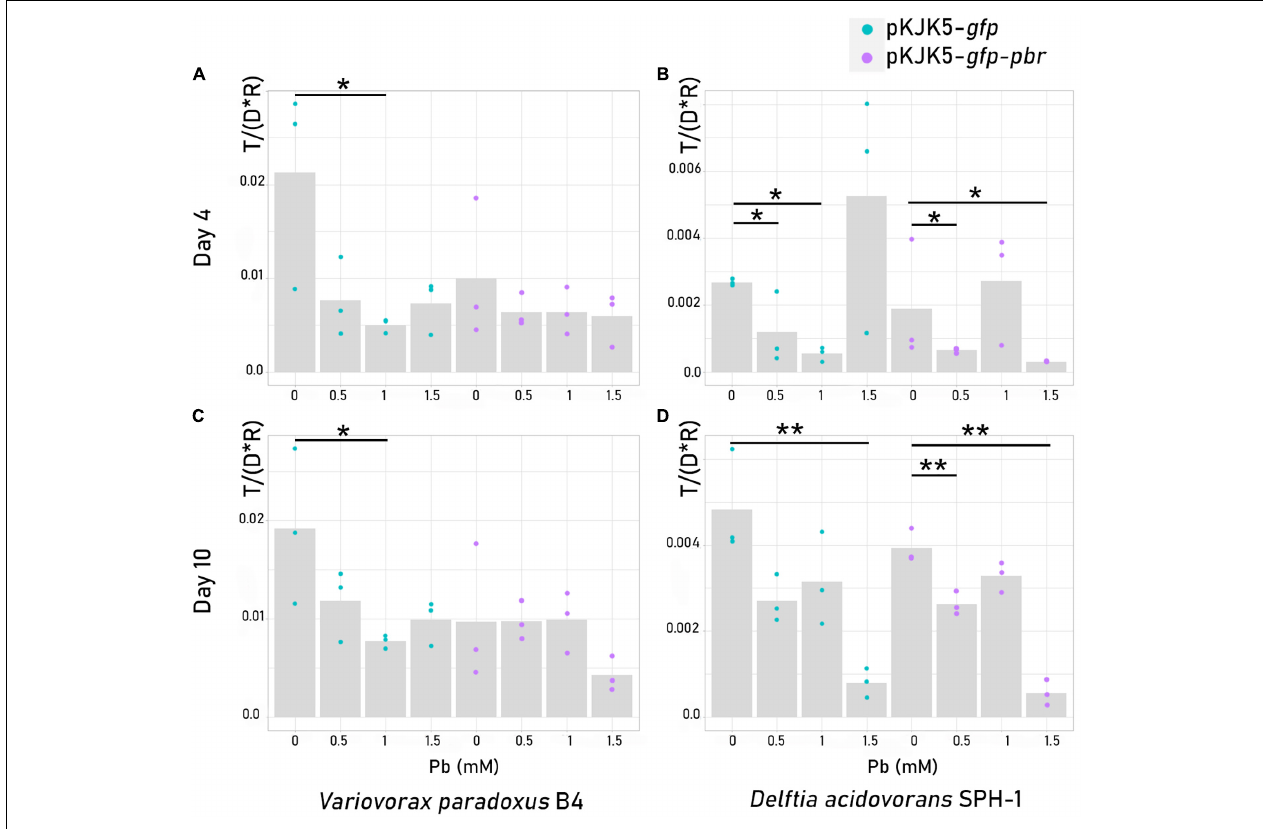
FIGURE 4 | Plasmid spread index [ T / ( D * R )] ± SEM in recipient cells, Variovorax paradoxus B4 (A,C) or Delftia acidovorans SPH-1 (B,D) , after 4 days (A,B) or 10 days (C,D) of mating. The p -values were calculated from Kruskal–Wallis tests (4-day mating) or log-2-transformed abundances using t -tests (10-day mating) depending on homoscedasticity. * p -value < 0.05; ** p -value < 0.01; *** p -value < 0.001 ( N = 3). The dotted lines are for pKJK5- gfp comparisons, and the continuous lines are for pKJK5- gfp-pbr